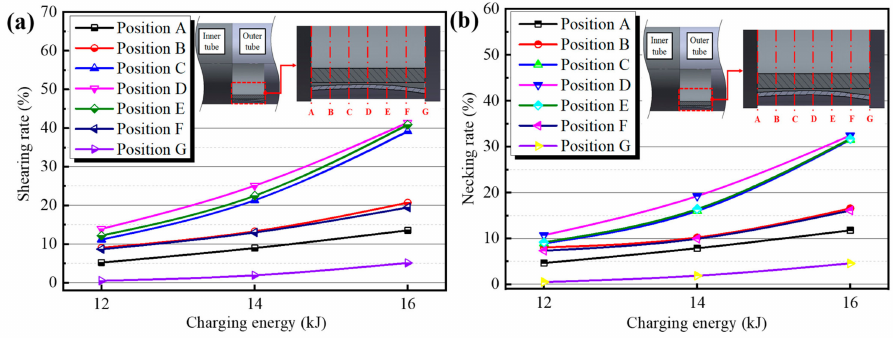
Figure 11. Detailed deformation of different positions under different discharge energies ( a ) shearing rate, ( b ) necking rate.